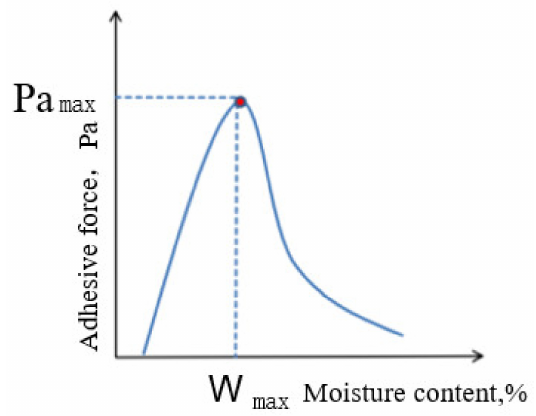
Figure 4. Correspondence curve for soil moisture content and adhesive